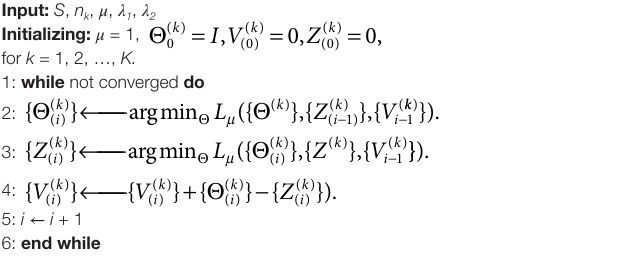
ALGORITHM 1 Framework of alternating direction method of multipliers